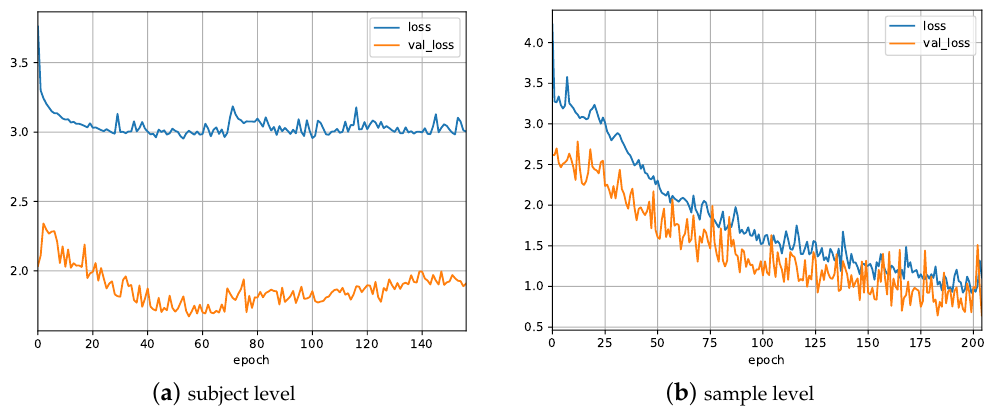
Figure 5. A typical loss versus epoch graph during the training of a deep neural network (DNN). The data has been split at ( a ) subject level or ( b ) sample level. Loss is the training loss and val_loss is the validation loss. The gap between the training and validation loss indicates the amount of over-fitting.